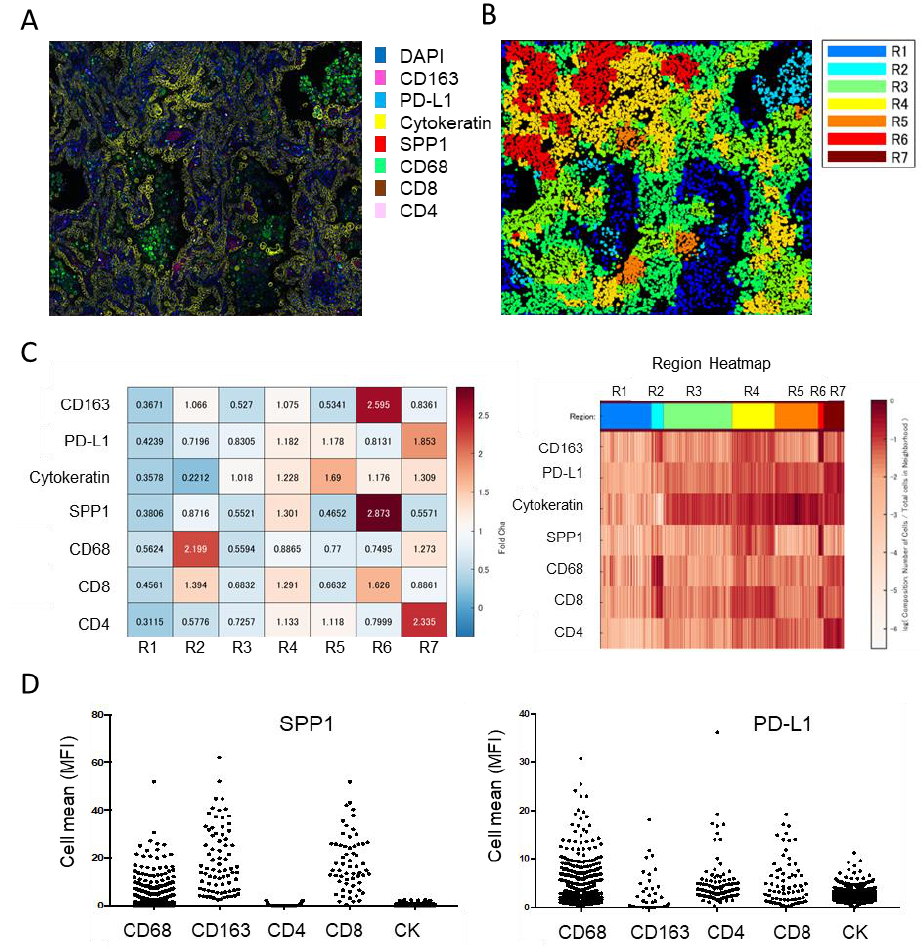
Figure 3. Multiplex immunofluorescent IHC analysis of lung adenocarcinoma. ( A ) IHC of CD163, PD-L1, cytokeratin, SPP1, CD68, CD8, and CD4 performed using the PhenoCycler™ (CODEX) system (AKOYA Bioscience, Marlborough, MA). ( B ) Spatial analysis of cluster neighborhood regions, with regions classified into 7 areas. ( C ) Tanle and Region Heatmap based on mean fluorescence intensity (MFI). MFI is normalized to the maximum MFI per neighborhood. ( D ) SPP1 and PD-L1 expression in each cell type presented in dot-blot graphs.